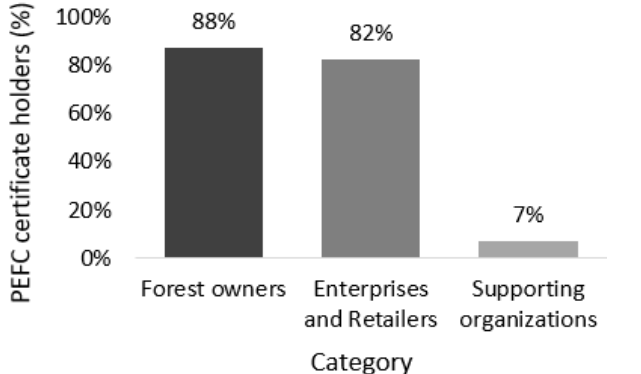
Figure 2. Percentage of respondents who already held a PEFC certification when they joined the initiative.